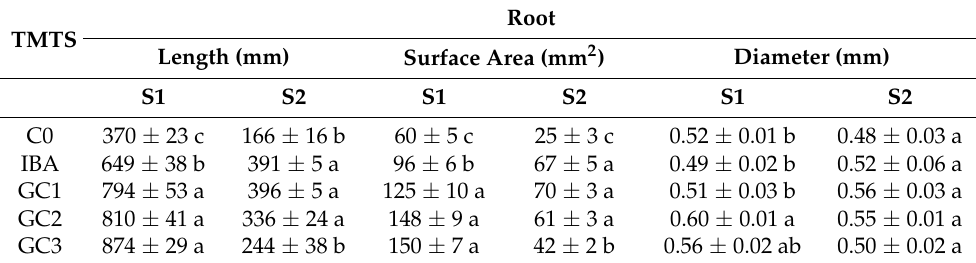
Table 5. Root morphological traits: root tips (no.), forks (no.) and crossings (no.) in Lantana camara (S1) and Abelia × grandiflora (S2), influenced by rooting promoters at different concentrations (C). Root TMTS Tips (No.) Forks (No.) Crossings (No.) S1 S2 S1 S2 S1 S2 C0 45 ± 2 d 32 ± 3 c 197 ± 4 d 79 ± 3 c 30 ± 3 c 13 ± 1 c IBA 97 ± 6 c 73 ± 3 a 430 ± 11 c 239 ± 4 a 81 ± 1 b 38 ± 1 a GC1 114 ± 5 b 68 ± 9 a 477 ± 14 c 242 ± 11 a 83 ± 3 b 38 ± 1 a GC2 116 ± 6 b 37 ± 3 c 613 ± 35 b 136 ± 3 b 84 ± 4 b 23 ± 2 b GC3 137 ± 5 a 53 ± 2 b 694 ± 16 a 128 ± 5 b 106 ± 2 a 19 ± 1